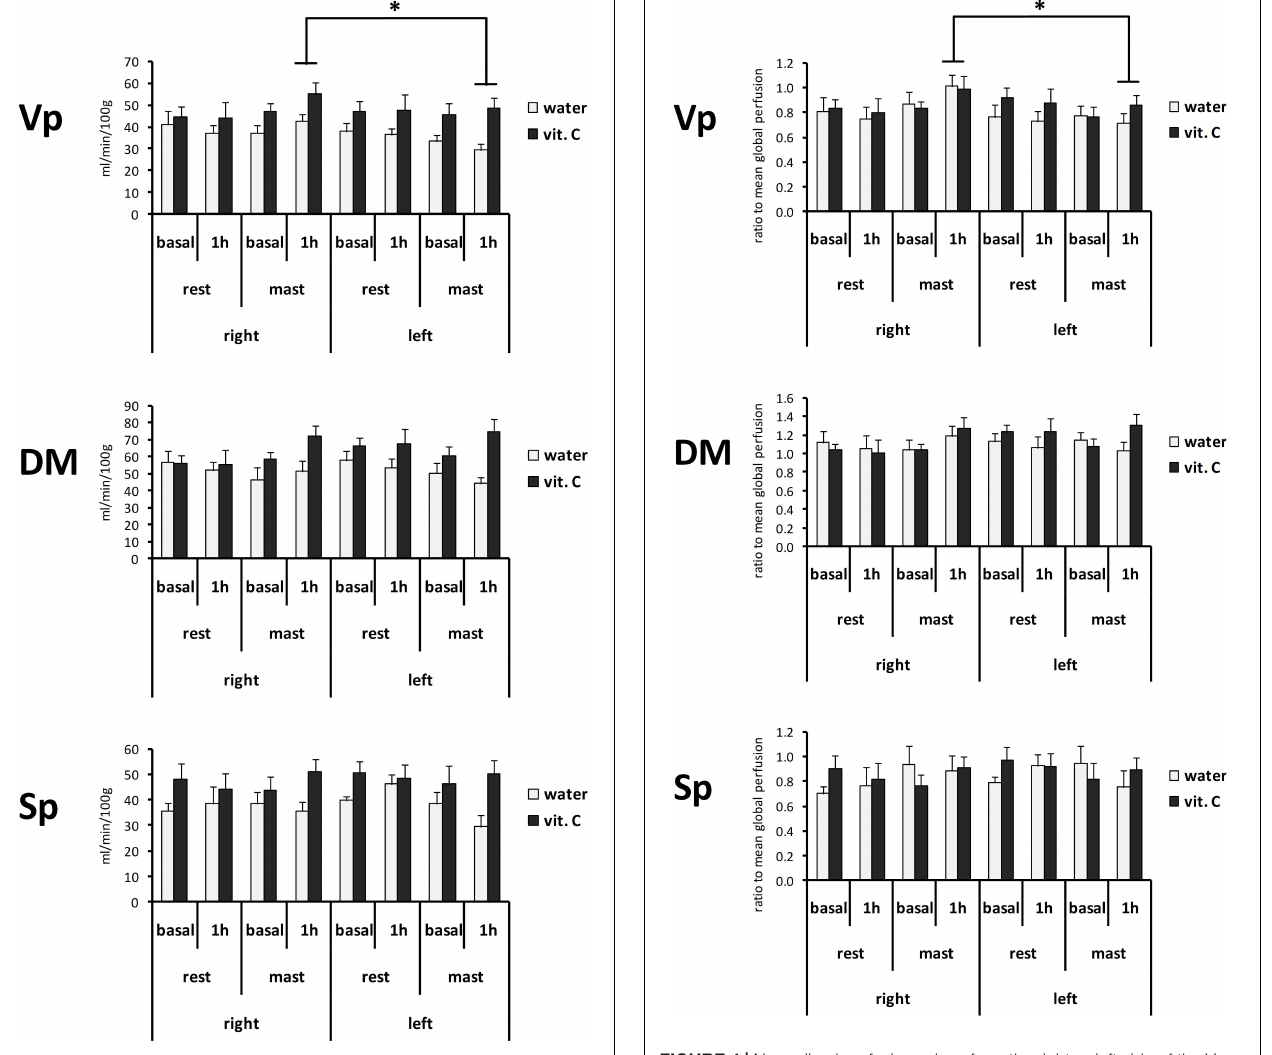
FIGURE 3 | Perfusion values from the right or left side of the Vp, DM, and Sp trigeminal nuclei. Bars represent the mean values obtained from the first (basal) or second (1 h) ASL-MRI scan, after a vit. C supplemented (vit. C) or control (water) lunch; the second scan was acquired after resting (rest) or masticating (mast) for 1 h. There was a significant effect for the water/vit. C factor in all nuclei. ∗ Tukey post hoc test, p < 0.05.